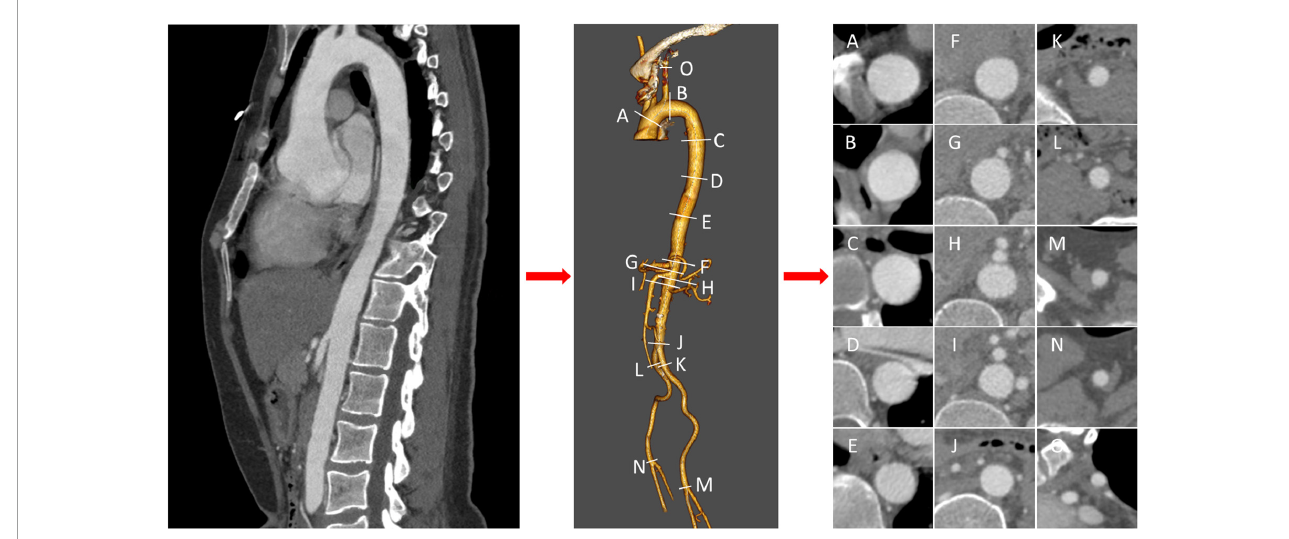
FIGURE1 Schematic diagram of measurements. After three-dimensional reconstruction of thoracic and abdominal aorta, landmarks were measured orthogonal to the centerline at labeled position (A–O) , and cross sections were acquired.